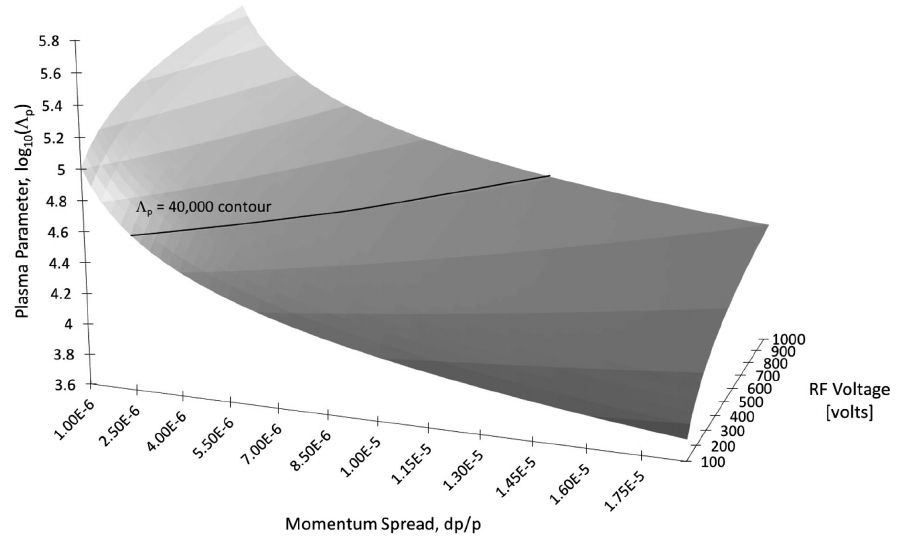
FIG. 3. The surface of values of the log 10 Λ p versus momentum spread and voltage for 7 Li þ ions with v 0 ¼ 100 m = s, at f 12 . 6 rf ¼